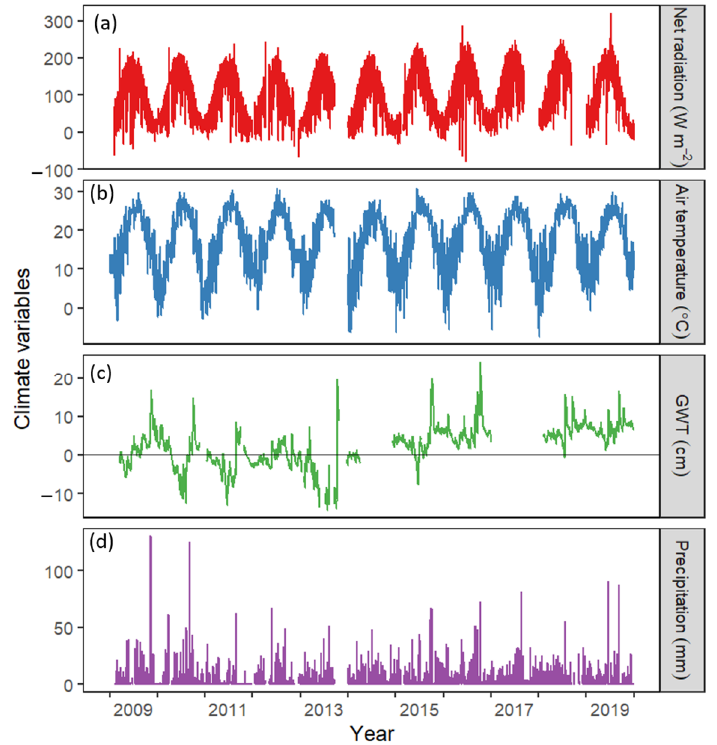
Figure 2. Seasonal variations in ( a ) net radiation (Rn), ( b ) air temperature (Tair), ( c ) groundwater table depth (GWT), and ( d ) precipitation. Daily data from 2009–2019 obtained from the eddy covariance flux tower in Alligator River National Wildlife Refuge, Dare County, North Carolina, USA was